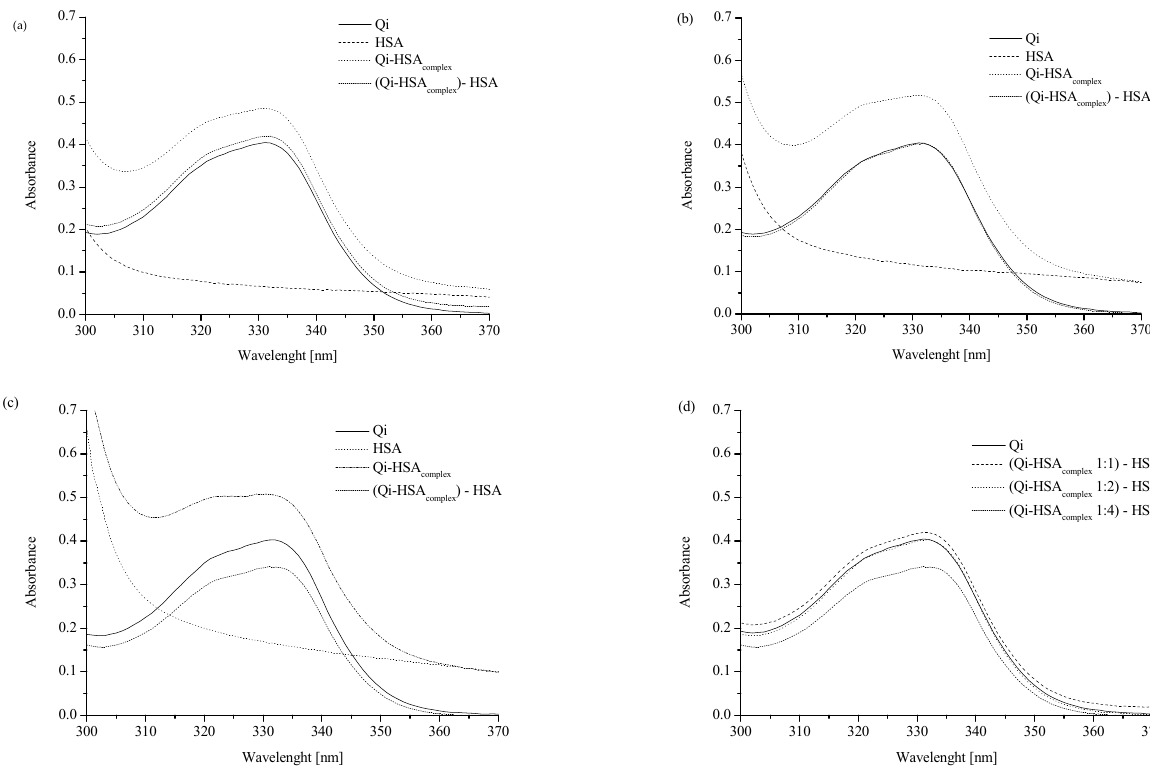
Figure 1. Absorption spectra of analyzed ligand–protein mixtures: ( a ) “Qi”, “HSA”, “Qi-HSA complex ” and “Qi calc = Qi-HSA complex − HSA” at ligand:protein 1:1 molar ratio; ( b ) “Qi”, “HSA”, “Qi-HSA complex ” and “Qi calc = Qi-HSA complex − HSA” at ligand:protein 1:2 molar ratio; ( c ) “Qi”, “HSA”, “Qi-HSA complex ” and “Qi calc = Qi-HSA complex − HSA” at ligand:protein 1:4 molar ratio; ( d ) “Qi”, “Qi calc 1:1 molar ratio”, “Qi calc 1:2 molar ratio” and “Qi calc 1:4 molar ratio”; [Qi] 7 × 10 − 5 M, [HSA] 7 × 10 − 5 M, 1.4 × 10 − 4 M, 2.8 × 10 − 4 M; all tested solutions were prepared in phosphate buffer (pH 7.4). Table 1. The values of mean absorbance for “Qi” and “Qi calc = Qi-HSA complex − HSA” at λ max 331 nm in Qi-HSA complex 1:1, 1:2, and 1:4 molar ratio; [Qi] 7 × 10 − 5 M, [HSA] 7 × 10 − 5 M, 1.4 × 10 − 4 M, 2.8 × 10 − 4 M; all tested solutions were prepared in phosphate buffer (pH